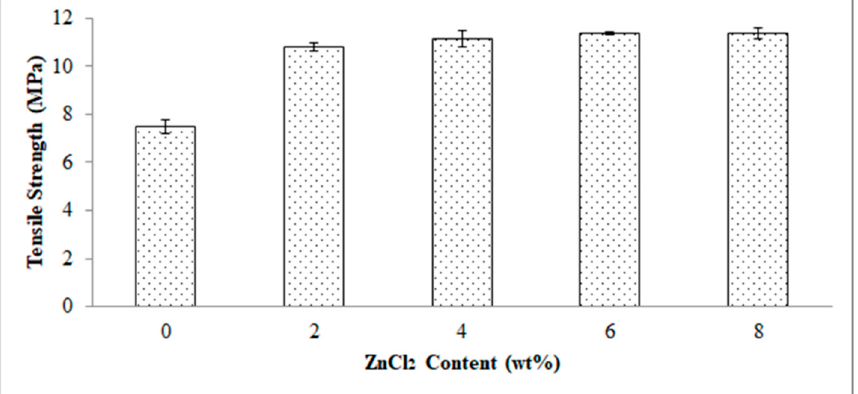
Figure 4. Effect of ZnCl 2 content on tensile strength of EVA/CWF composites.